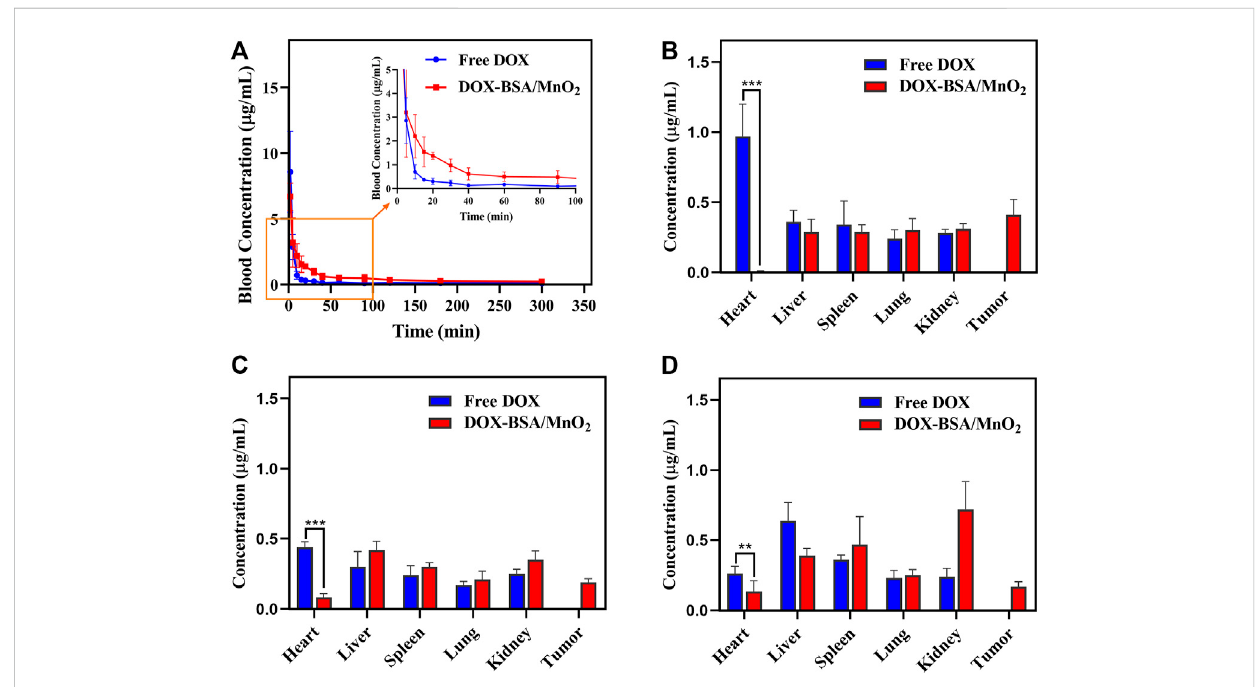
FIGURE 3 (A) Plasma concentration-time curve of DOX solution along with DOX-BSA/MnO 2 NPs in rats after single IV injection; n = 6; concentration in different organs and tumors (B) at 1 h; (C) 8 h and; (D) 24 h after IV injection of free DOX solution together with DOX-BSA/MnO 2 NPs in mice; n = 6.